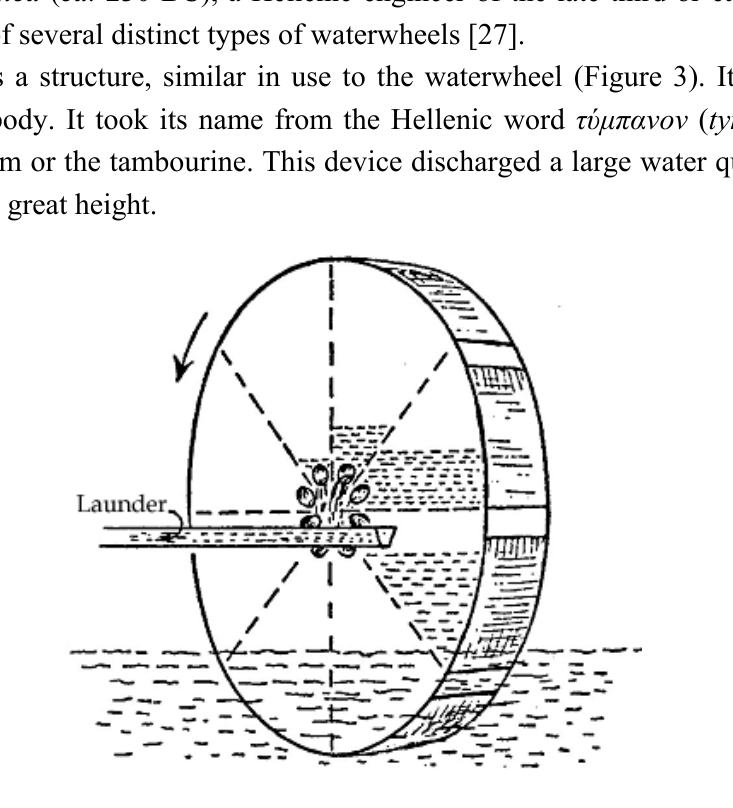
Figure 3. The Tympanon (adapted from